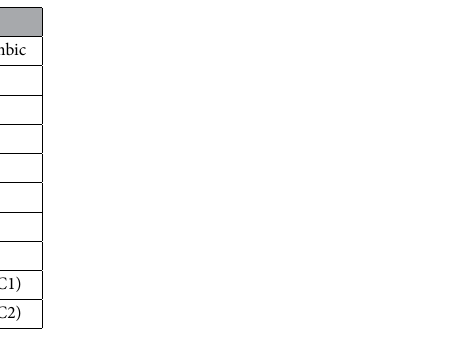
Table 1. Structure, lattice constants, phase transition temperature T C , and spin–lattice relaxation time T 1ρ of